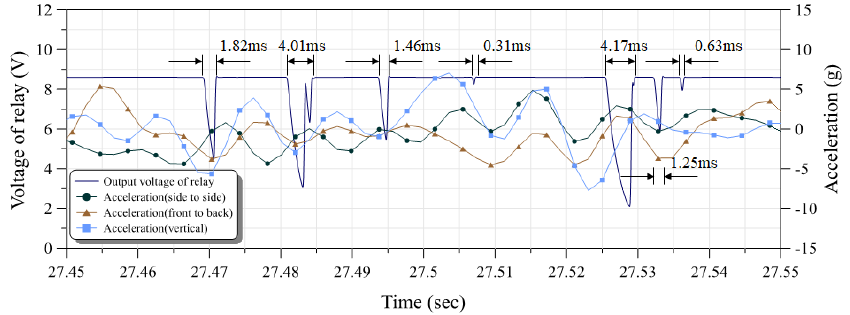
Figure 16. Single chatter recorded on relay contact during CRS (PGA 0.75 g).